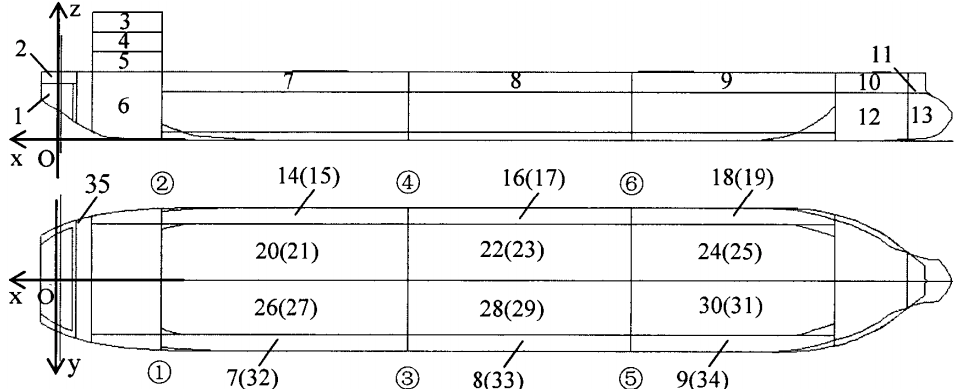
Figure 1. Schematic diagram of hull and compartments. 1. FWT.C, 2. STEAR.C, 3.